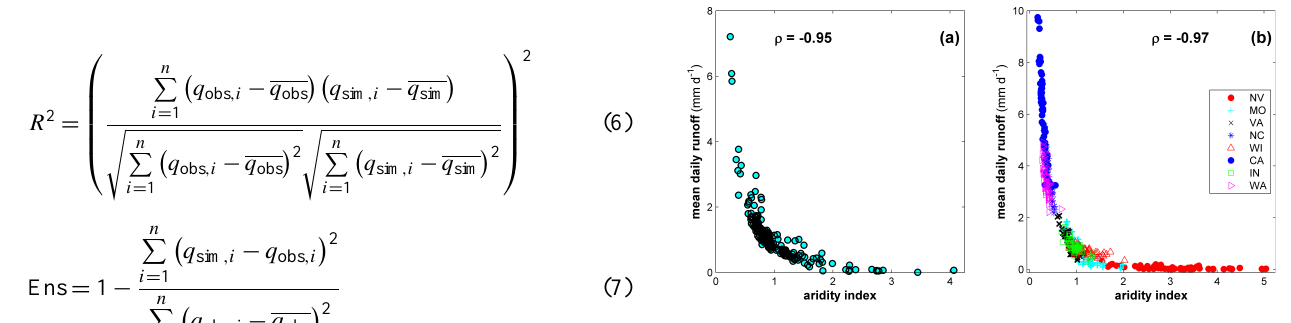
Fig. 2. Nature of the relationship between mean daily streamflow and aridity index (AI) (a) across 197 catchments (between catch- ment variability), and (b) across many years (inter-annual variabil- ity) for 8 selected catchments. The Spearman’s rank correlation co- efficients (i.e., Spearman’s ρ ) are − 0.95 and − 0.97,